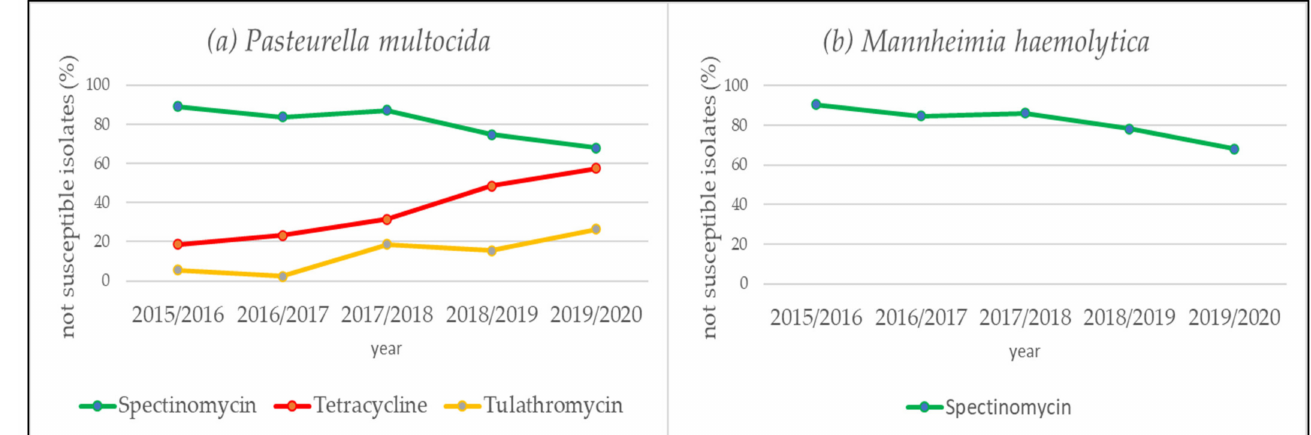
Figure 2. Statistically significant trends regarding the not susceptibility of P. multocida ( a ) and M. haemolytica ( b ) over the five-year period in Bavaria, Germany. For spectinomycin a significant decrease in not susceptibility could be observed in P. multocida (OR = 0.70; 95% CI: 0.56–0.86; p < 0.001) ( a ) and in M. haemolytica isolates (OR = 0.71; 95% CI: 0.55–0.90; p =